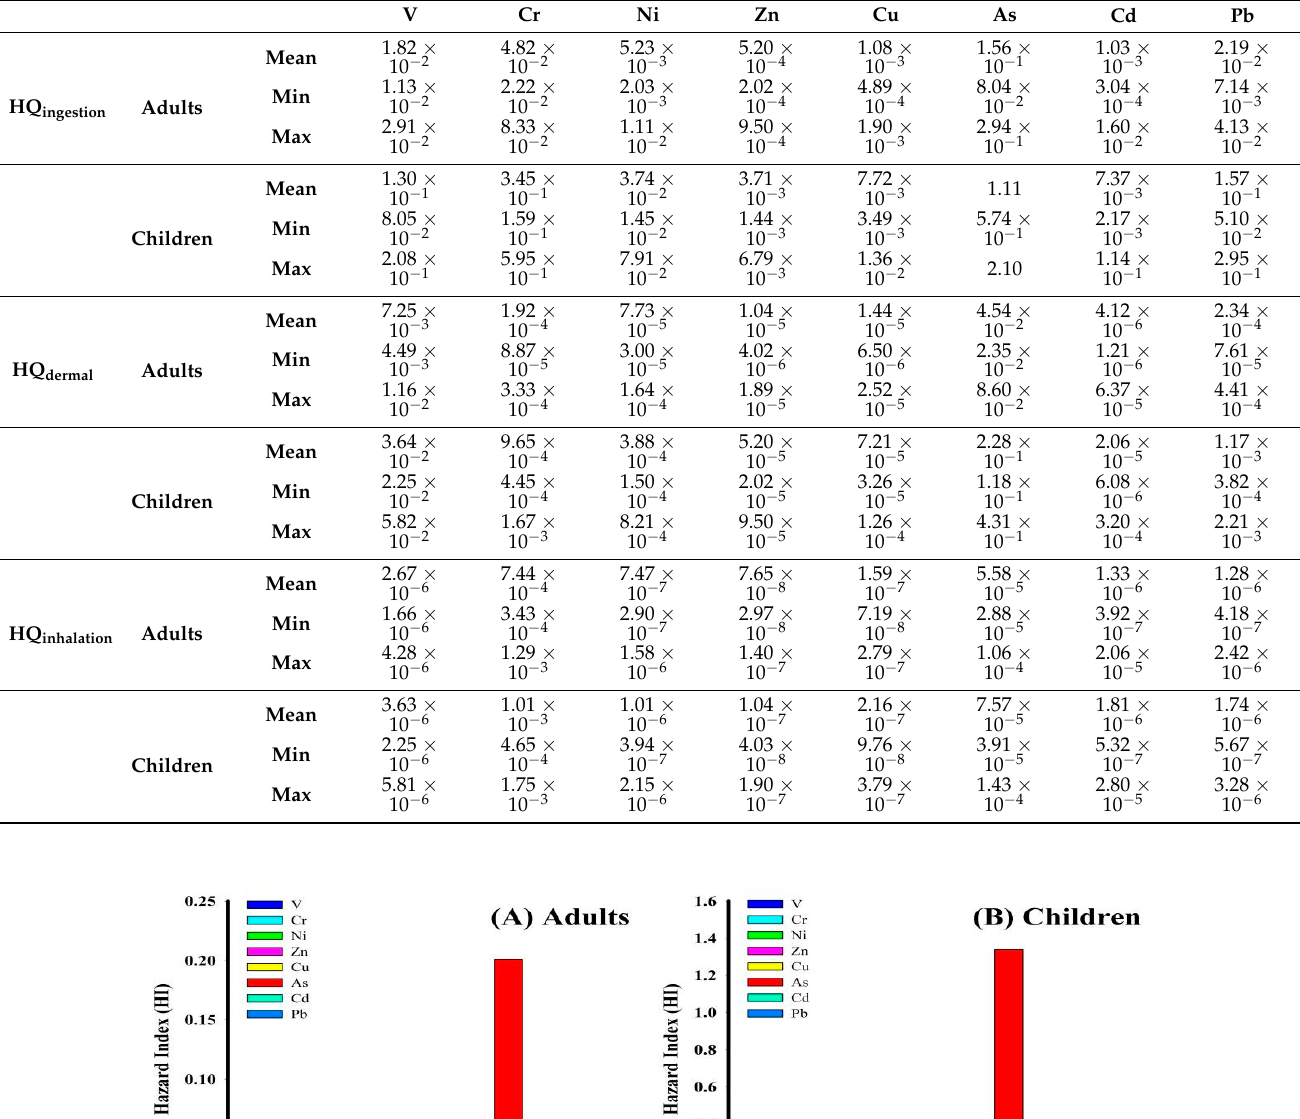
Table 2. The total metals daily intakes (mg/kg/day) via different exposure pathways and hazard index (HI) (noncarcinogenic health risk) in adults and children.